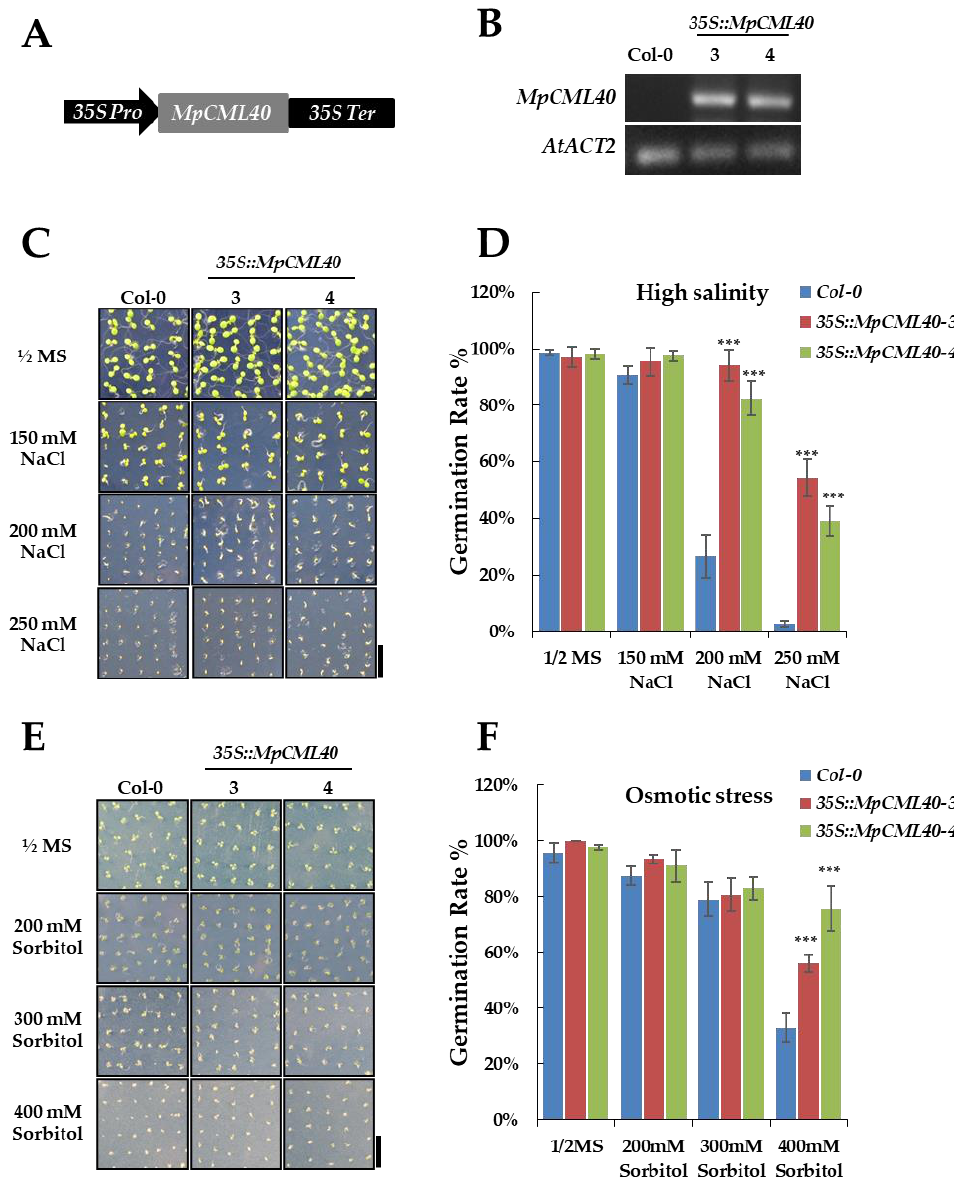
Figure 6. Effects of MpCML40 on seed germination rate under salt and osmotic stress. ( A ) Schematic structure of the MpCML40 expression construct. 35S Pro , cauliflower mosaic virus 35S promoter. 35S Ter , cauliflower mosaic virus 35S terminator. ( B ) Expression levels of the MpCML40 gene in the wild-type and transgenic Arabidopsis plants were analyzed by RT-PCRs using the MpCML40 full-length primers listed in Table 2. AtACT2 ( ACTIN2 ) was used as a control. ( C-F ) Typical phenotype and germination rate of wild-type and transgenic Arabidopsis seeds germinated on ½ MS medium containing different concentrations of NaCl ( C , D ) and sorbitol ( E , F ). Bar = 1 cm. Error bars show mean values (±SD) of germination rate of three independent plates. *** p < 0.001 (Student’s t -test).